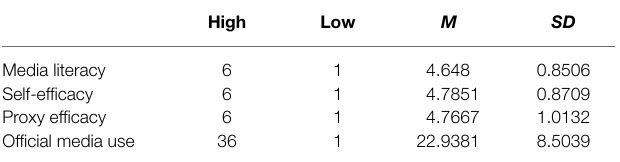
TABLE 1 | Descriptive statistics of major